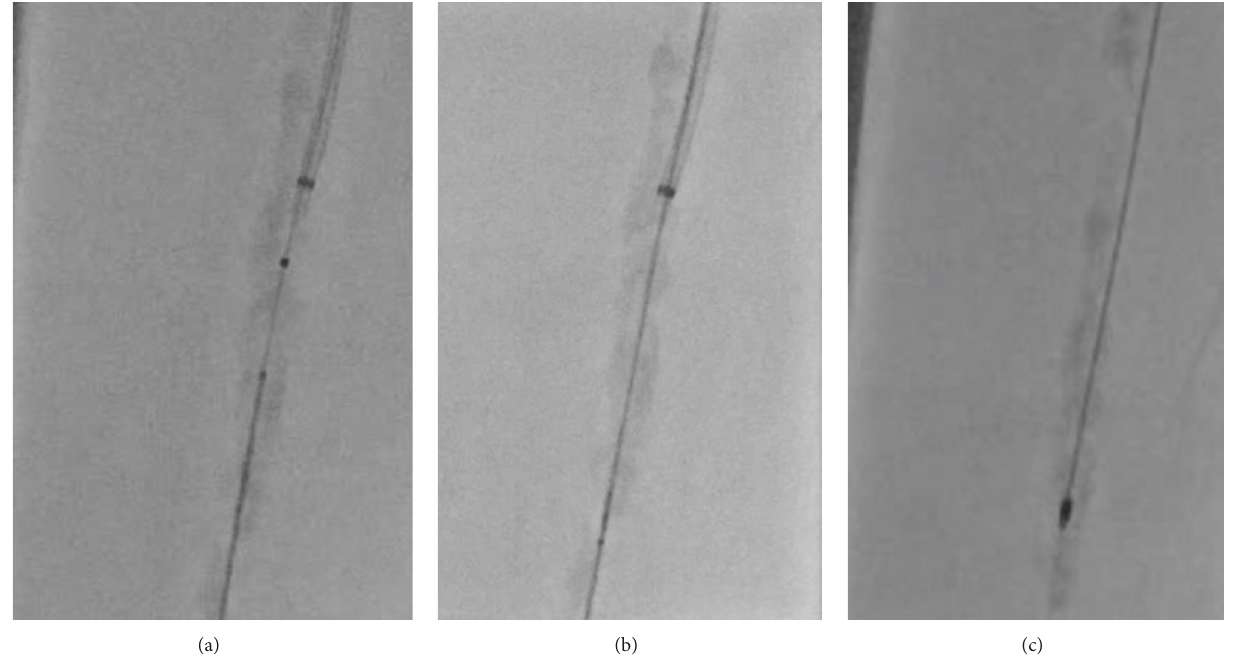
Figure 4: Combined strategy of the excimer laser atherectomy and high-speed rotational atherectomy. (a) The excimer laser catheter (Turbo Elite 0.9 mm) also cannot cross the lesion; however, it modifies the morphology of the chronic total occlusion lesion. (b) The Caravel microcatheter can pass the lesion. (c) Exchanging to the 0.009-inch Rota-wire from the conventional 0.014-inch wire, 1.5 mm burr ablation is performed.